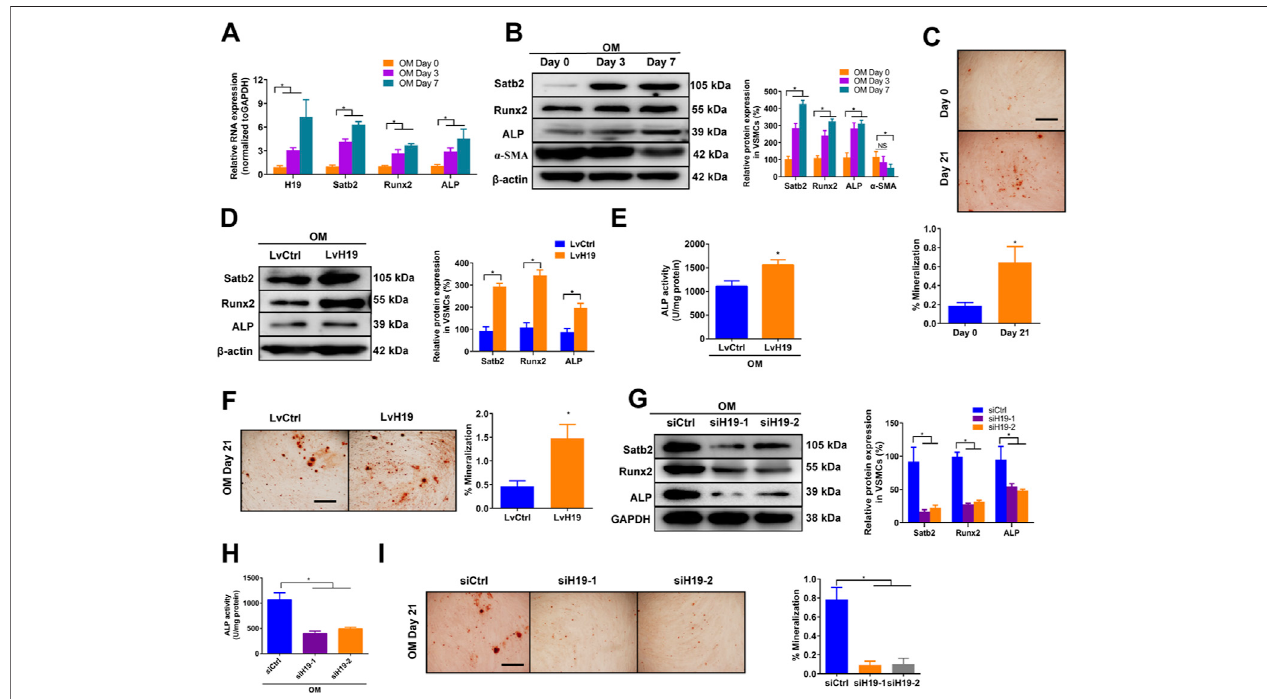
FIGURE1| |H19promotesosteogenicdifferentiationand mineralizationofVSMCstreatedwithosteogenicmedium. (A,B) ExpressionofH19,calci fi cationmarker genes Runx2 and ALP, and Satb2 during the osteogenic differentiation of VSMCs. VSMCs were treated with osteogenic medium (OM) that contains 10 mM ß - glycerophosphate ( β -GP) for 7 days to induce osteogenic differentiation. (A) Expression of H19, Runx2, ALP, and Satb2 were determined by qRT-PCR. (B) Expression ofRunx2,ALP, a -SMAandSatb2weredeterminedbyWesternblotting.Thedatawerepresentedasdensitometricratiosnormalizedto ß -actin[ (B) ,rightpanel]. (C) Alizarin Red S staining were measured in VSMCs incubated with ß -GP for 21 days. Representative microscopic views are shown. Data were presented as ratio of positive staining area (lower panel). (D – F) VSMCs were treated with OM along with either lentivirus containing full length of H19 cDNA (LvH19) or control cDNA (LvCtrl). The protein expression of Runx2, ALP, and Satb2 were determined by Western blotting in VSMCs after treatment for 2 days (D) . Data were presented as densitometric ratiosnormalizedtoGAPDH[ (D) ,rightpanel].TheALPactivitywasdeterminedbyanElisakitinVSMCsaftertreatment2 days (E) .AlizarinRedSstainingweremeasured in VSMCs after treatment for 21 days. Representative microscopic views are shown (F) . Scale bar represents 200 µm. Data were presented as ratio of positive staining area[ (F) ,rightpanel]. (G – I) VSMCswereincubatedwithOMmediumalongwitheitherH19siRNA(siH19)orcontrolsiRNA(siCtrl).TheproteinexpressionofRunx2,ALP, and Satb2were determined byWestern blotting aftertreatmentfor2 days (G) .Datawerepresentedasdensitometric ratios normalized toGAPDH[ (G) ,right panel].The ALPactivity wasdetermined byanElisakitinVSMCsafter treatment for2 days (H) .AlizarinRedSstainingweremeasured inafter treatment for21 days.Representative microscopicviewsareshown (I) .Scalebarrepresents200 µm.Datawerepresented asratioofpositivestainingarea[ (I) ,rightpanel].Eachexperiment wasrepeatedfor three times. The data represent the mean ± SD of triplicates. * p <